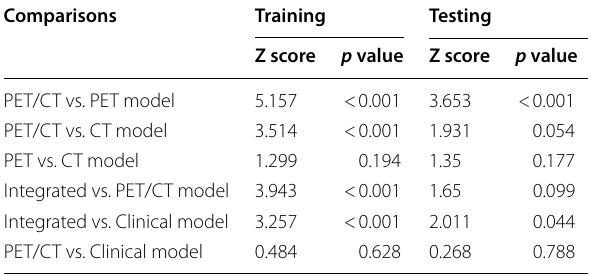
The PET/CT, PET, and CT models represent PET/CT, PET, and CT radiomics models,respectively; integrated model represent PET/CT radiomics-clinical